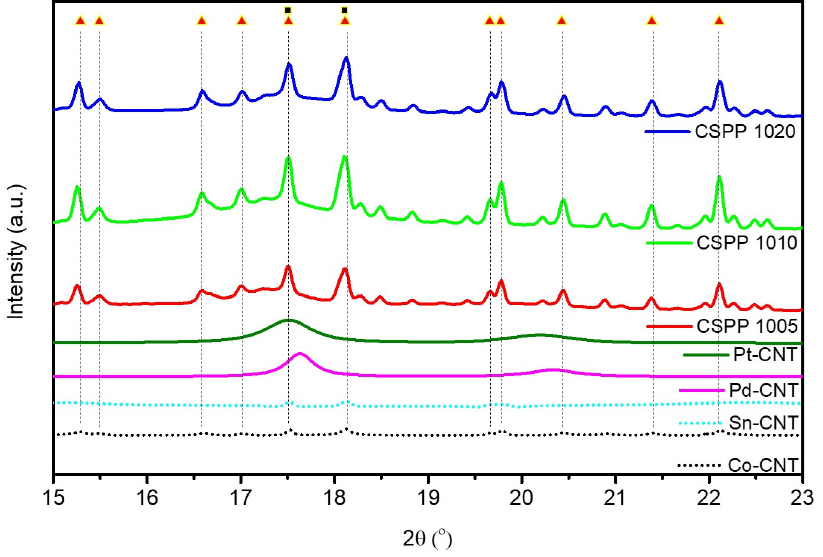
Figure 2. X-ray diffraction patterns of CSPP NCs and control samples. All the spectra were measured under the incident X-rays of 18 keV. X-ray absorption spectroscopy (XAS) at Pt L 3 -edge and Pd K-edge is employed to get more insights into the local atomic and electronic structure of CSPP NCs with varying Sn/Pd ratios. Figure 3a depicts the normalized X-ray absorption near edge spectra (XANES) of CSPP NCs and Pt-CNT at Pt L 3 -edge. The absorption edge (A) in the Pt L 3 - edge XANES spectra of CSPP NC reflects the electronic transition from 2p to 5d orbital, whereas the absorption edge intensity (H A ) corresponds to the occupied/unoccupied den- sity of Pt 5d orbital (i.e., the extent of electron transfer from neighbouring atoms to Pt- atoms) and the amount of surface chemisorption of oxygen species [27]. It is consistently reported in the literature that a higher density of occupied Pt d-orbitals is favourable for the ORR performance of electrocatalysts [24]. As shown in Figure 3a, the H A follows the trend CSPP 1020 > CSPP 1010 > CSPP 1005. Accordingly, the CSPP 1005 NC exhibits the lowest H A , suggesting the highest occupied density of the Pt d-orbital and can be at- tributed to the electron localization around the Pt clusters; therefore, the CSPP 1005 NC exhibits the highest ORR activity. Moreover, the identical position of inflection points for CSPP NCs to Pt-CNT confirms their similar metallic characteristics in all the samples. Fur- thermore, in the coordination environment around target atoms (Pt in this case), the ex- tended X-ray absorption fine structure (EXAFS) analysis was used. Figure 3b shows the Fourier-transformed (FT)-EXAFS spectra of CSPP NCs with different Sn/Pd ratios and Pt- CNT at Pt L 3 -edge, whereas the corresponding structural parameters are listed in Table 1. Accordingly, CSPP 1005 NC shows the coordination numbers (CN)s of 3.86 and 0.842, respectively, for the Pt-Pt and Pt-Pd bond pairs, suggesting the formation of atomic-scale Pt-clusters with some extent of Pt-Pd heteroatomic intermixing (i.e., PtPd alloy formation). In addition, the CSPP 1005 NC exhibits the smallest CN for the Pt-Sn bond pair (CN Pt-Sn = 0.955) among all samples, which can be attributed to the lowest extent of galvanic replace- ment reaction between Pt 4+ ←→ Sn 0 and can be attributed to the lowest Sn loading in CSPP 1005 sample. Further increasing the Sn/Pd ratio to 1.0 leads to the higher kinetics of gal- vanic replacement reaction between Pt 4+ ←→ Sn 0 and thus, the CN for the Pt-Sn bond pair (CN Pt-Sn = 1.178) is increased. On the other hand, the CN for the Pt-Pd bond pair (CN Pt-Pd =